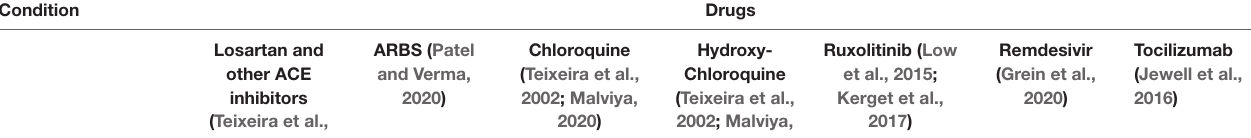
TABLE 2 | Comorbidities associated with COVID-19 patients and respective drugs with possible mechanisms which may show impact on these patients.